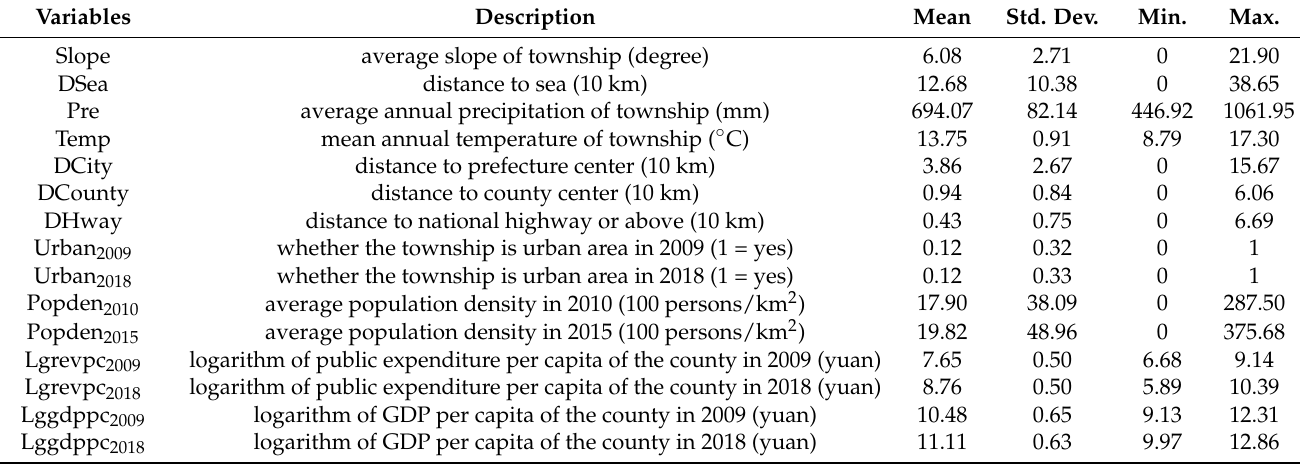
Table 2. Descriptive statistics of independent